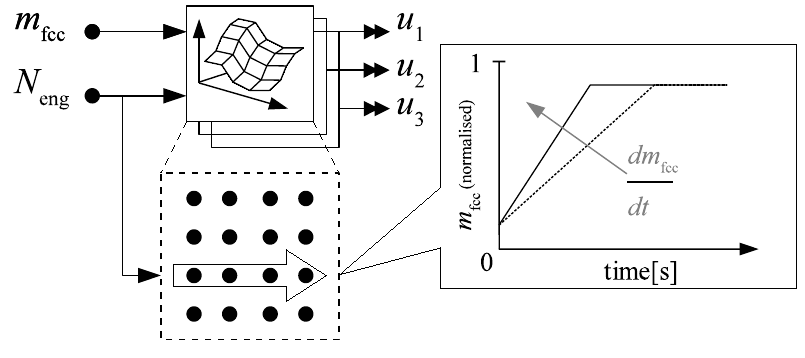
Figure 1. Feedforward (FF) control based on the steady-state actuator set-point maps.